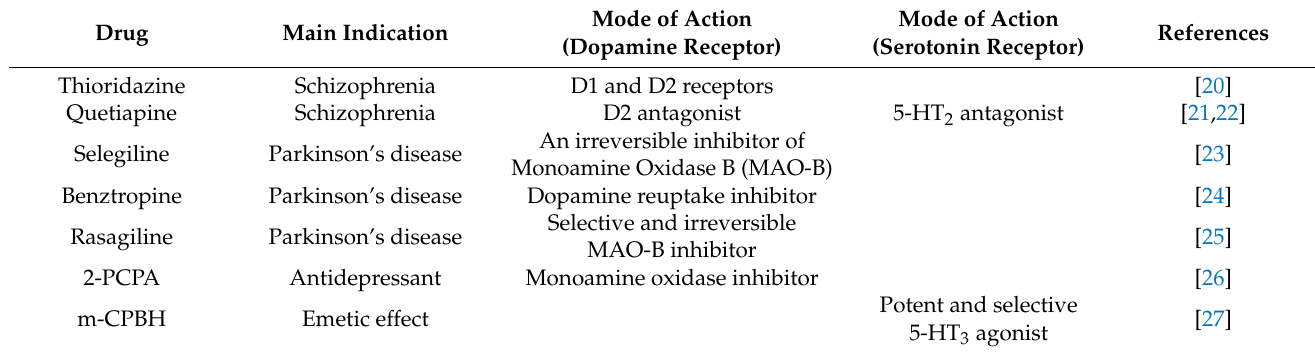
Table 1. List of drugs selected for repurposing with their main indication and the neurotransmitter receptors of action.